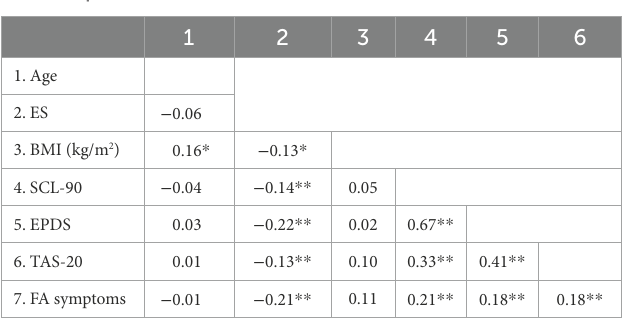
TABLE 3 Spearman’s correlation matrix for continuous variables.